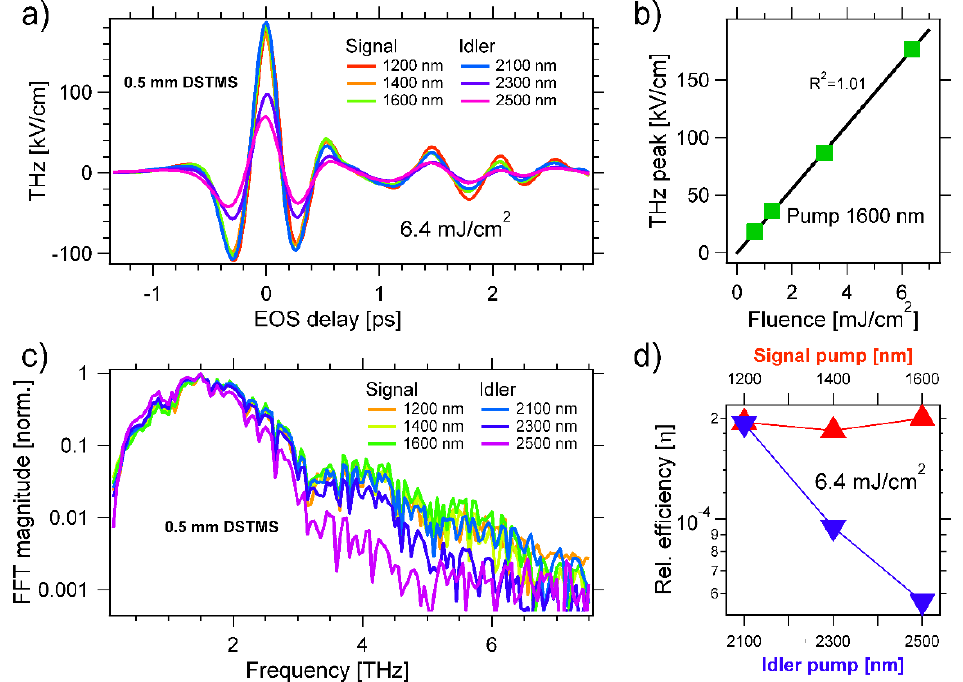
Figure 4. ( a ) THz emission by a ~0.5 mm thick 4-N,N-dimethylamino-4’-N’-methyl-stilbazolium 2,4,6-trimethylbenzenesulfonate (DSTMS) crystal. The pump fluence is set to 6.4 mJ/cm 2 . The THz is detected by EOS, see text for details. ( b ) We set the pump to λ P = 1600 nm, vary the pump fluence, and detect the peak THz field at t EOS = 0 ps. We obtain a linear trend that can be fitted with an R 2 value of 1.01. ( c ) Normalized spectrum of the THz field generated for different pump wavelengths. The spectrum is broader in DSTMS than in either GaP (Figure 2) or OH1 (Figure 3), with high frequency components extending over the entire detectable region [126]. ( d ) Estimated efficiency of the THz generation in DSTMS pumped in the NIR. The efficiency, largest between 1200 and 2100 nm, and amounts to ca. η ~2 × 10 − 4 .